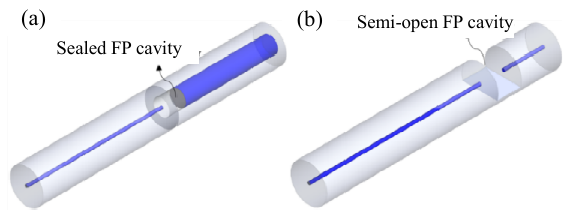
Fig. 18 Schematic diagrams of the inline EPI structure with